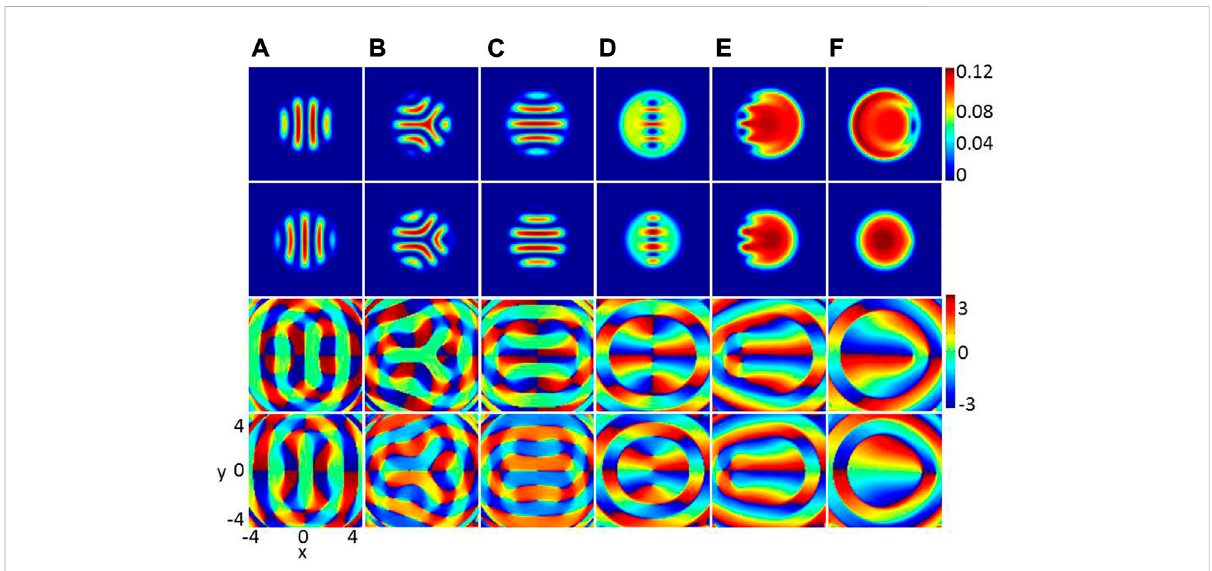
FIGURE 2 (Color online)Ground states of two-component BECs with DDI and D-SOC in an anharmonic trap, where β 11 = 50, β 22 = 100, β 12 = 150, and k = 3. (A) ε dd = 0, (B) ε dd = 0.4, (C) ε dd = 1.5. (D) ε dd = 3.5, (E) ε dd = 5 and (F) ε dd = 8. The rows from top to bottom denote | ψ 1 | 2 , | ψ 2 | 2 , arg ψ 1 , and arg ψ 2 , respectively. The unit length is a 0